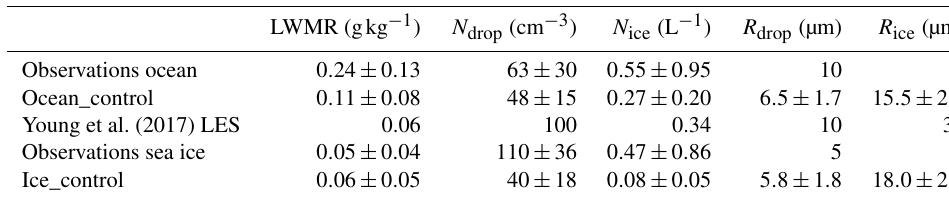
Table 2. Averaged ( ± 1 standard deviation) cloud properties derived from the ACCACIA in situ observations (Young et al., 2016, 2017), the Young et al. (2017) LES, and the ocean_control and ice_control simulations (as temporal means over 2–20h). As in the observations, all modeled quantities represent in-cloud values (cloud liquid content q c > 0 . 01gm − 3 for LWMR, N drop , and R drop and cloud ice content q i > 0 . 001gm − 3 for N ice and R ice ).